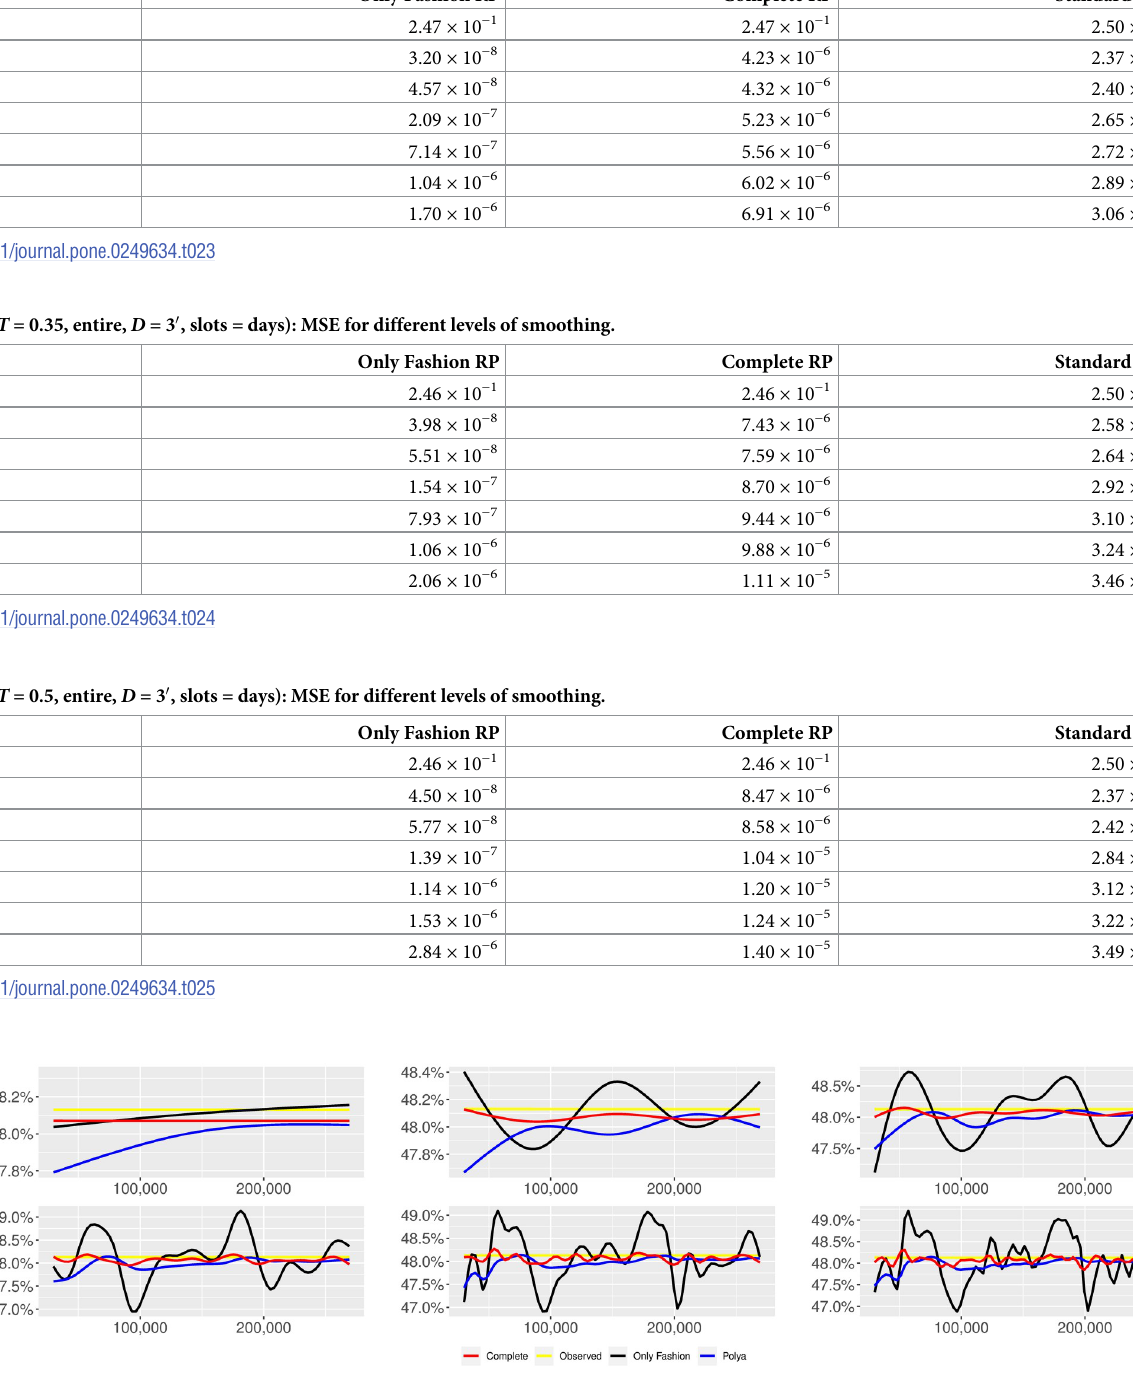
Table 23. “Covid” ( T = 0, entire, D = 3 0 , S = 100 slots of equal size): MSE for different levels of smoothing. smoothing